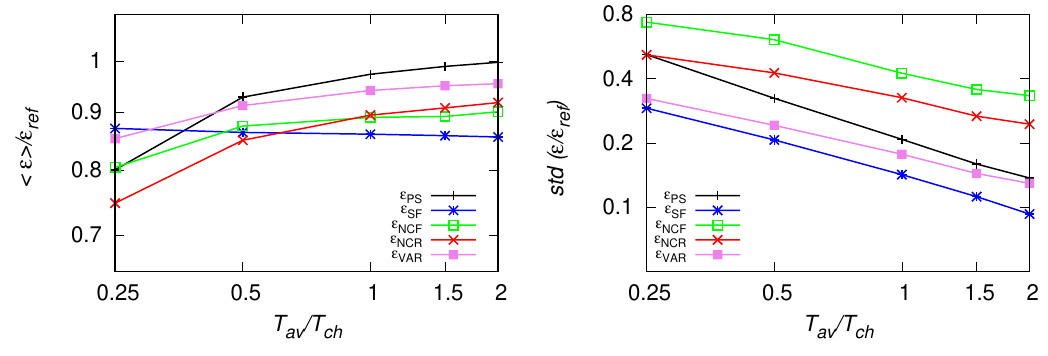
Figure 5. As in Figure 4, but for the fitting range f = [ 5 ÷ 10 ] Hz.